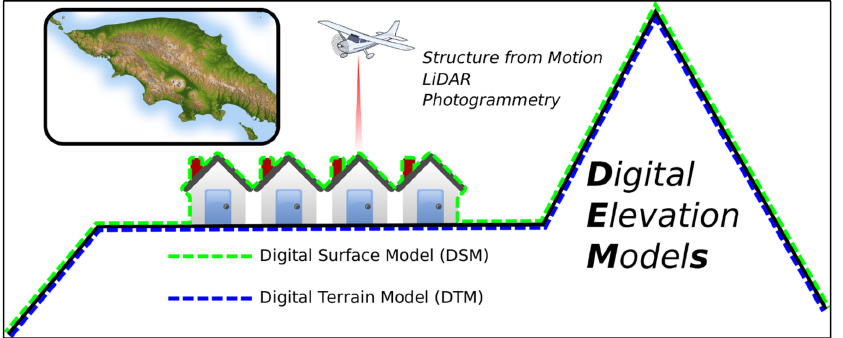
Figure 1. Visualization of Digital Elevation Models (DEMs), depicted as Digital Surface Models (DSMs)—green dashed line; and Digital Terrain Models (DTMs)—blue dashed line. Adapted from Arbeck [15].